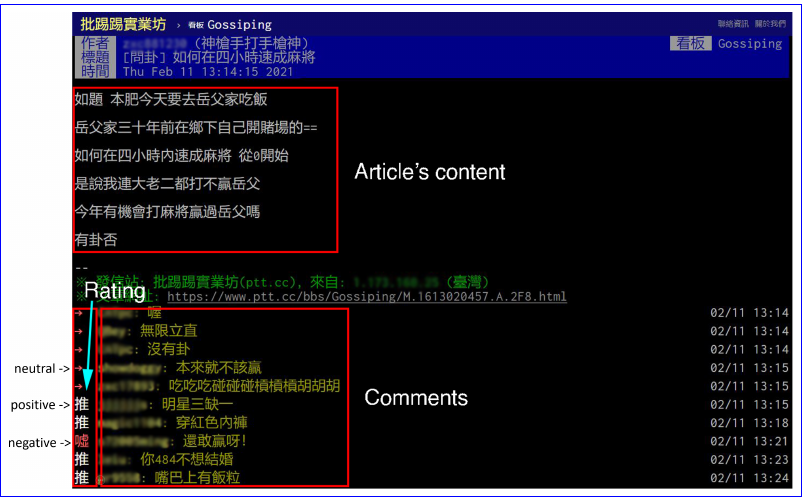
Figure 2. Screenshot of an article posted on PTT (https://www.ptt.cc/bbs/Gossiping/M.1613020457 .A.2F8.html (accessed on 11 February